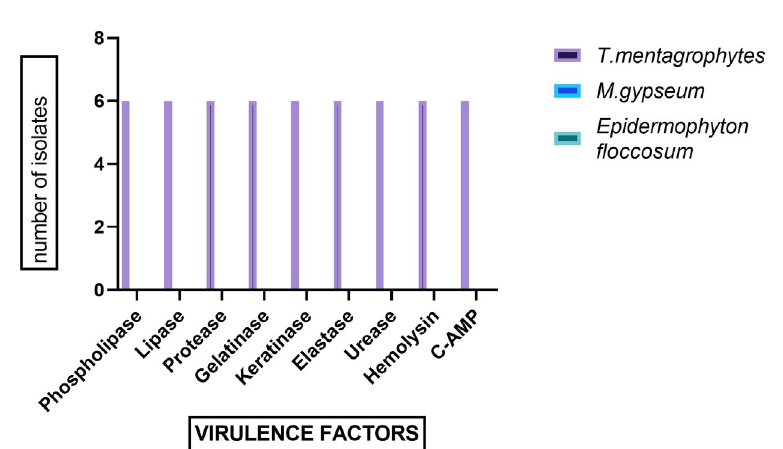
Fig. 5. Distribution of various virulence